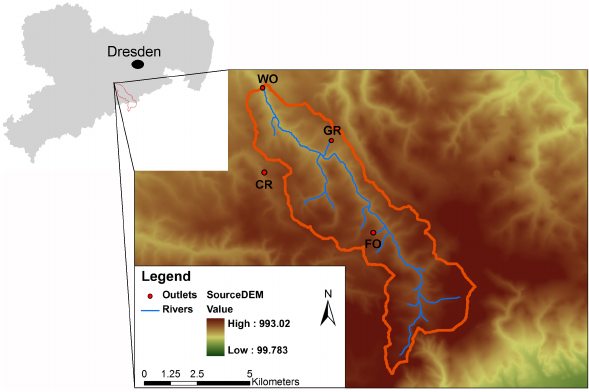
Fig. 1. Lehnm¨uhle watershed with the “Watershed Outlet” (WO) and the catchments “Crops” (CR), “Grassland” (GR), and “Forest” (FO). DEM values are in meters. Source: ATKIS-DGM25 (Ger- many), S-JTSK (Czech Republic), LfUG (S¨achsisches Landesamt f¨ur Umwelt und Geologie)